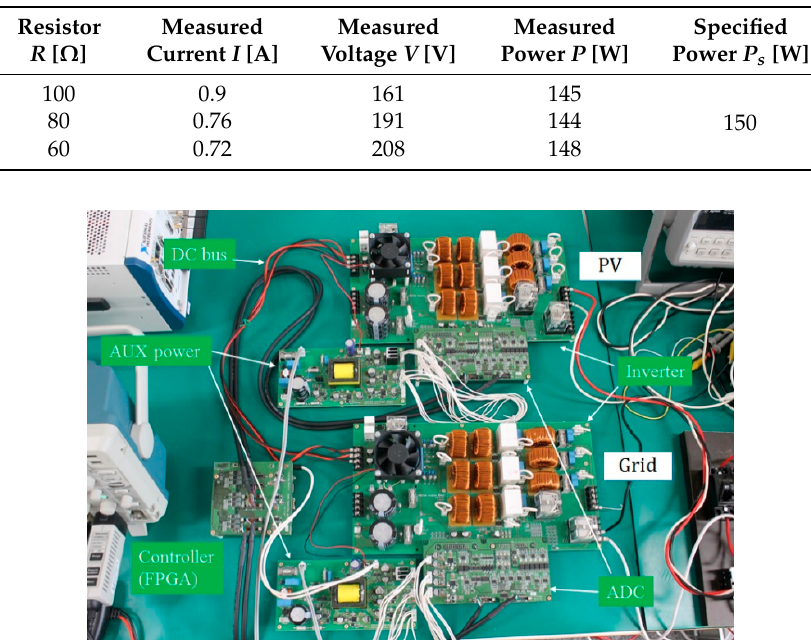
Table 2. Experimental result data for SPPT control.